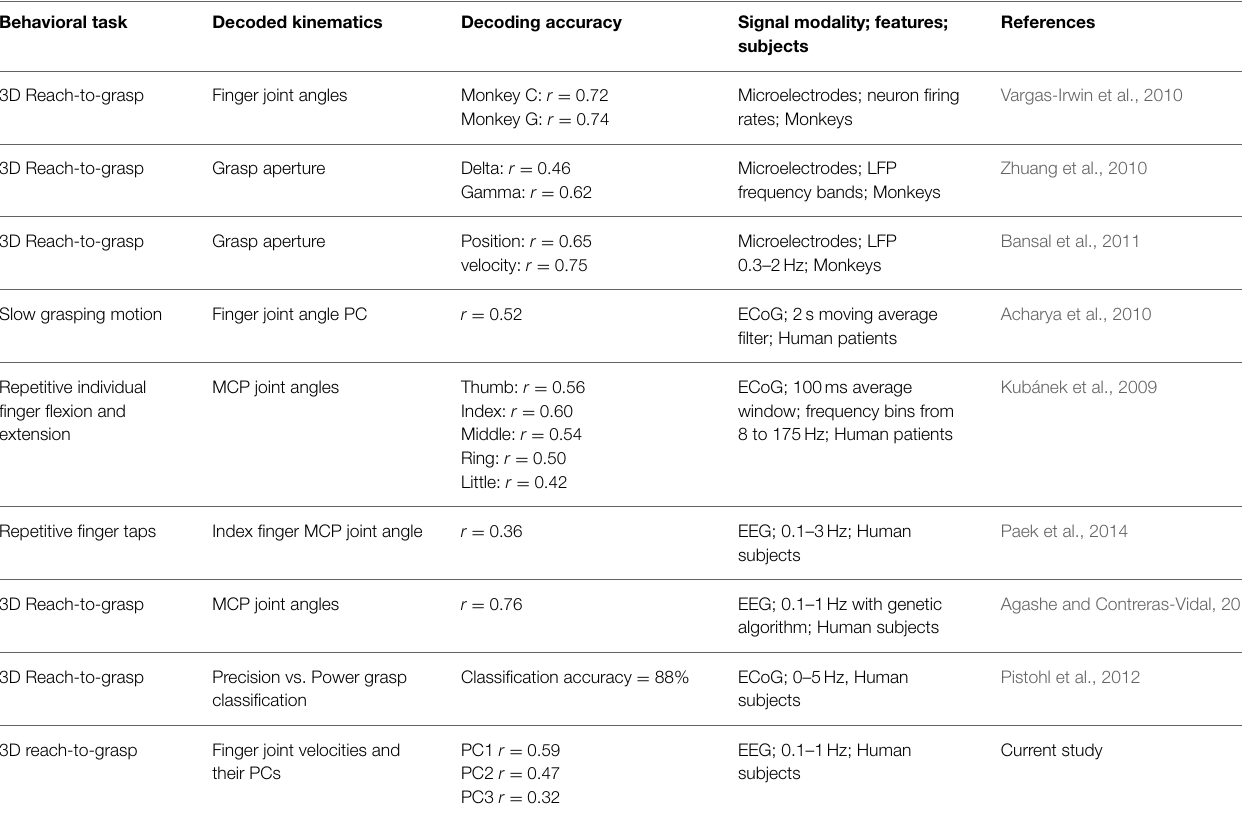
TABLE 1 | Summary of grasp decoding